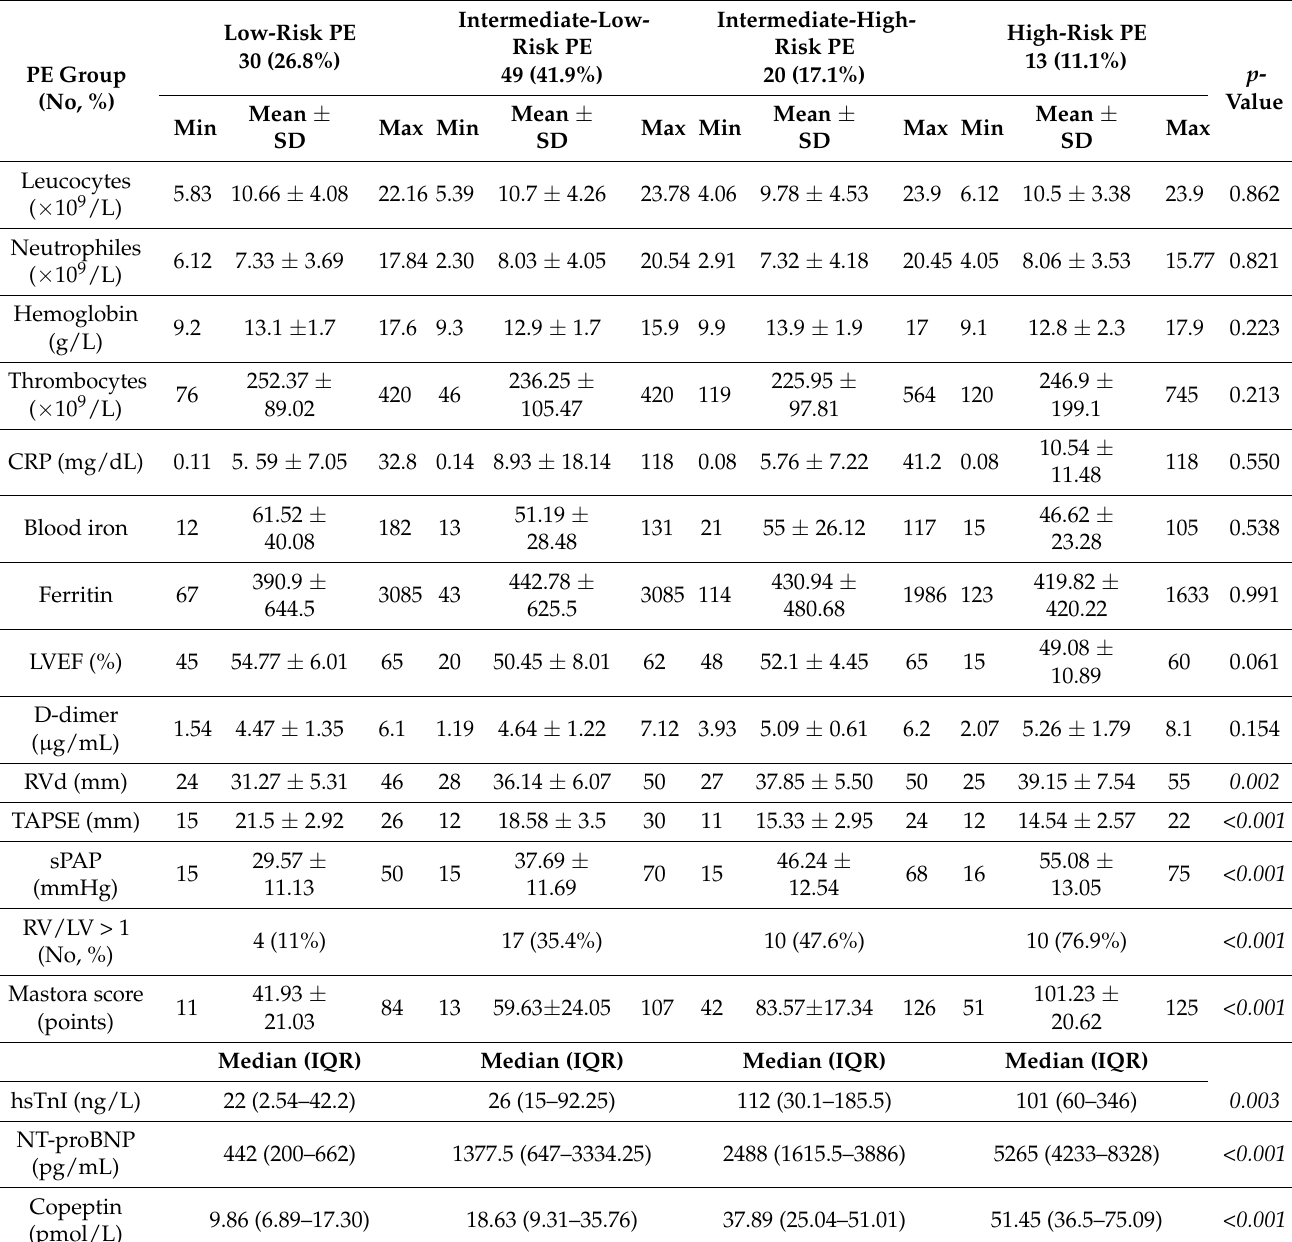
Table 3. Biological and imagistic parameters of PE